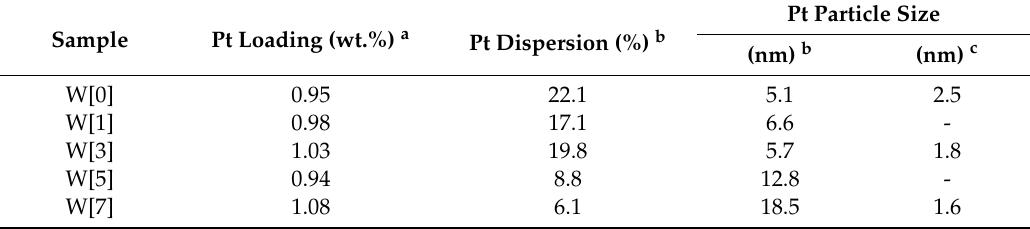
Table 3. Particle size and dispersion of platinum as determined by CO pulse chemisorption and TEM analysis.